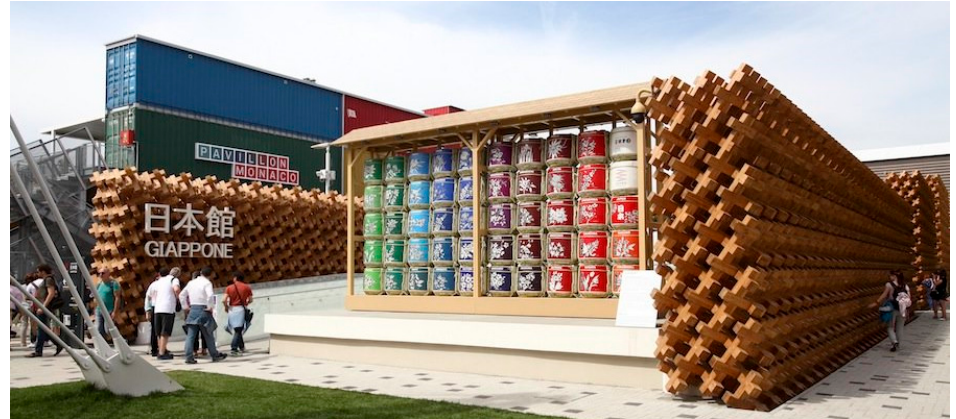
Figure 10. The Japan Pavilion at Expo 2015 in Milan (source: official web site of Expo 2015).